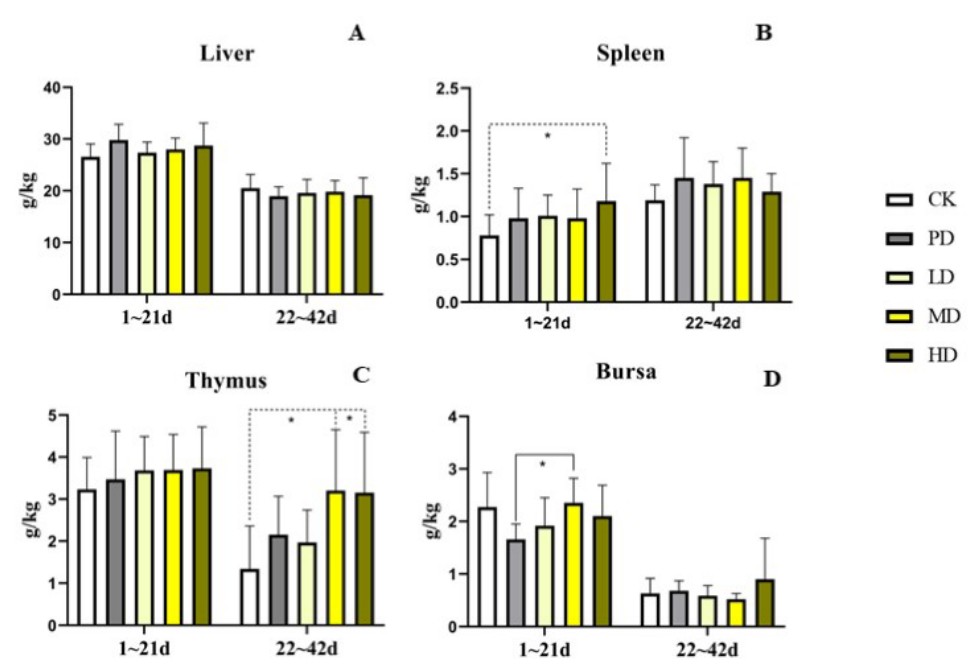
Figure 4. Effects of the fruit extract of K. coccinea on immune organ index of white-feather broilers ( A ): liver organ index; ( B ): spleen organ index; ( C ): thymus organ index; ( D ): bursa organ index; Note: Dotted line: compare with CK group; Solid line: compare with PD group; * indicate significant differences between groups according to the Tukey test; Supplementary Materials Table S4.